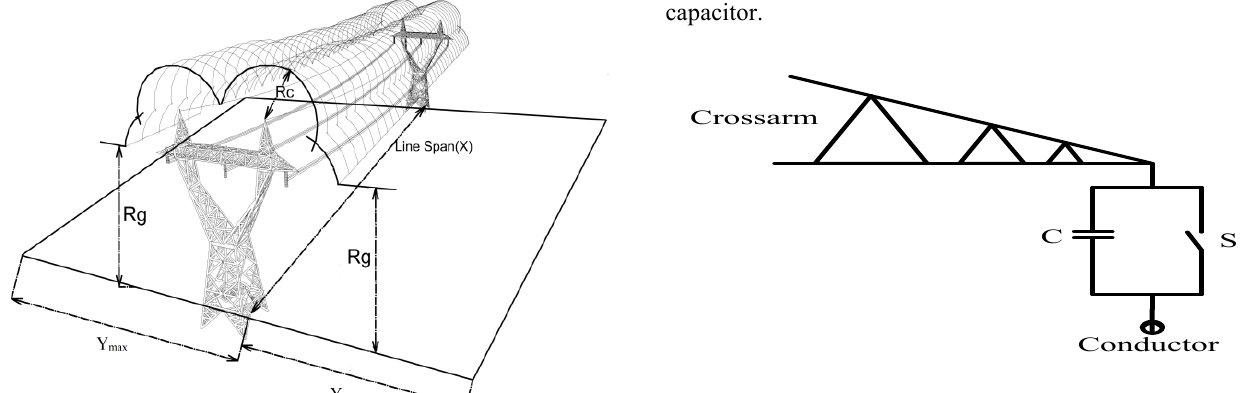
Figure 1: Impact area of lightning strokes on the ground.